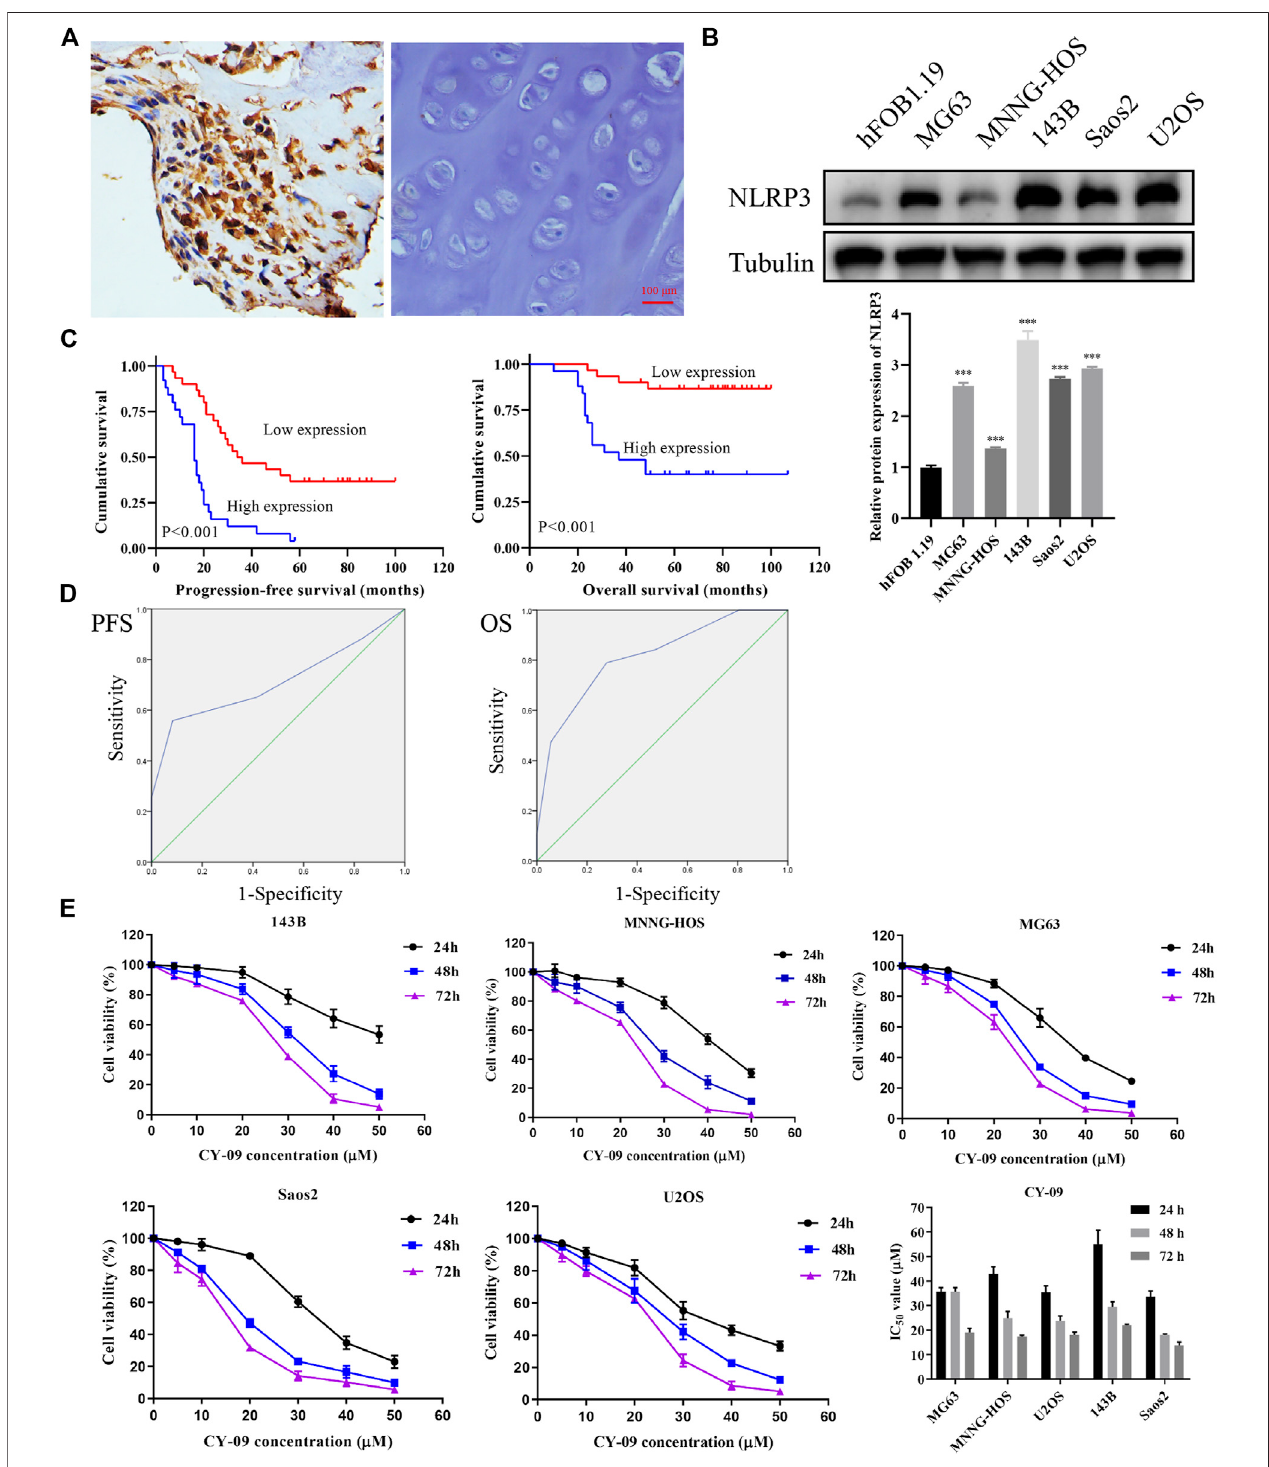
FIGURE 1 | NLRP3 expression in osteosarcoma and cell viability changes after CY-09 administration (A) NLRP3 expression in osteosarcoma and osteochondroma tissues (B) NLRP3 expression in hFOB 1.19 and osteosarcoma cell lines (C) Prognostic value of NLRP3 for patients with osteosarcoma (D) ROC curves for PFS and OS in osteosarcoma with different expression scores of NLRP3 protein (E) Cell viability changes in osteosarcoma cells after treatment with different concentrations of CY-09. The NLRP3 expression in cells and the cell viability were measured in triplicate.